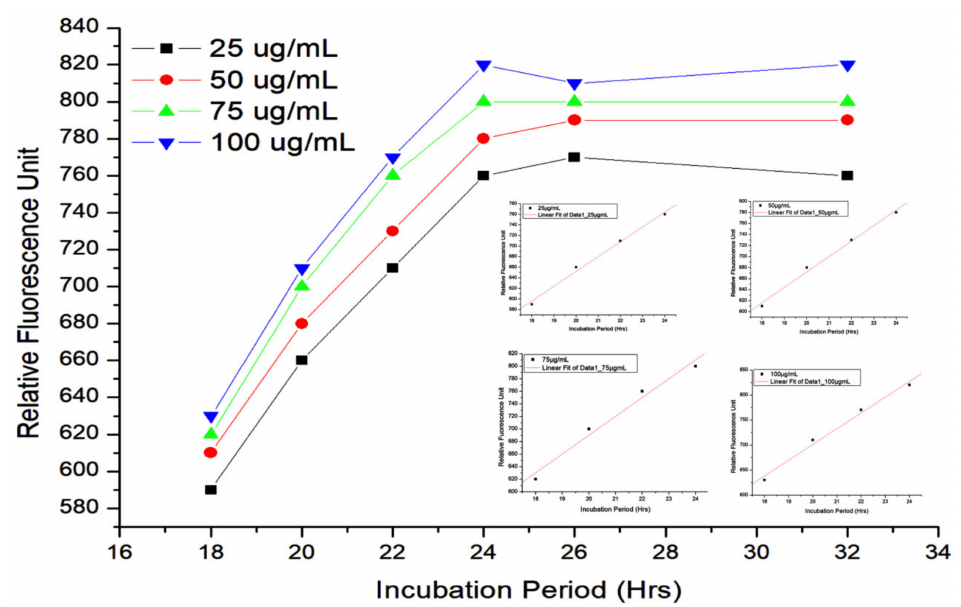
Figure 3. Cell-based DCFH-DA assay graph of ROS estimation. Note: Each bar represents the mean of two technical duplicates of an independent experiment and the corresponding standard deviations.